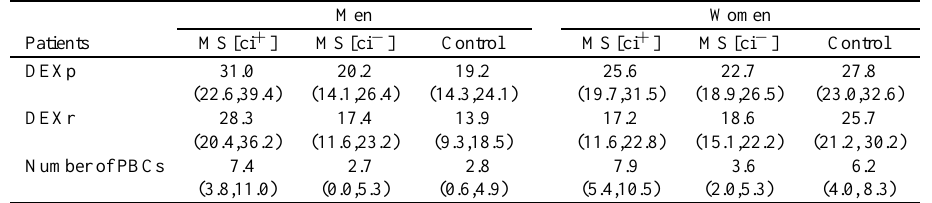
Table 6 Estimated mean of DEX scores and the number of PBCs with 95% confidence intervals adjusted for MS (with [ci − ] and without [ci + ] cognitive impairment) and control groups and gender